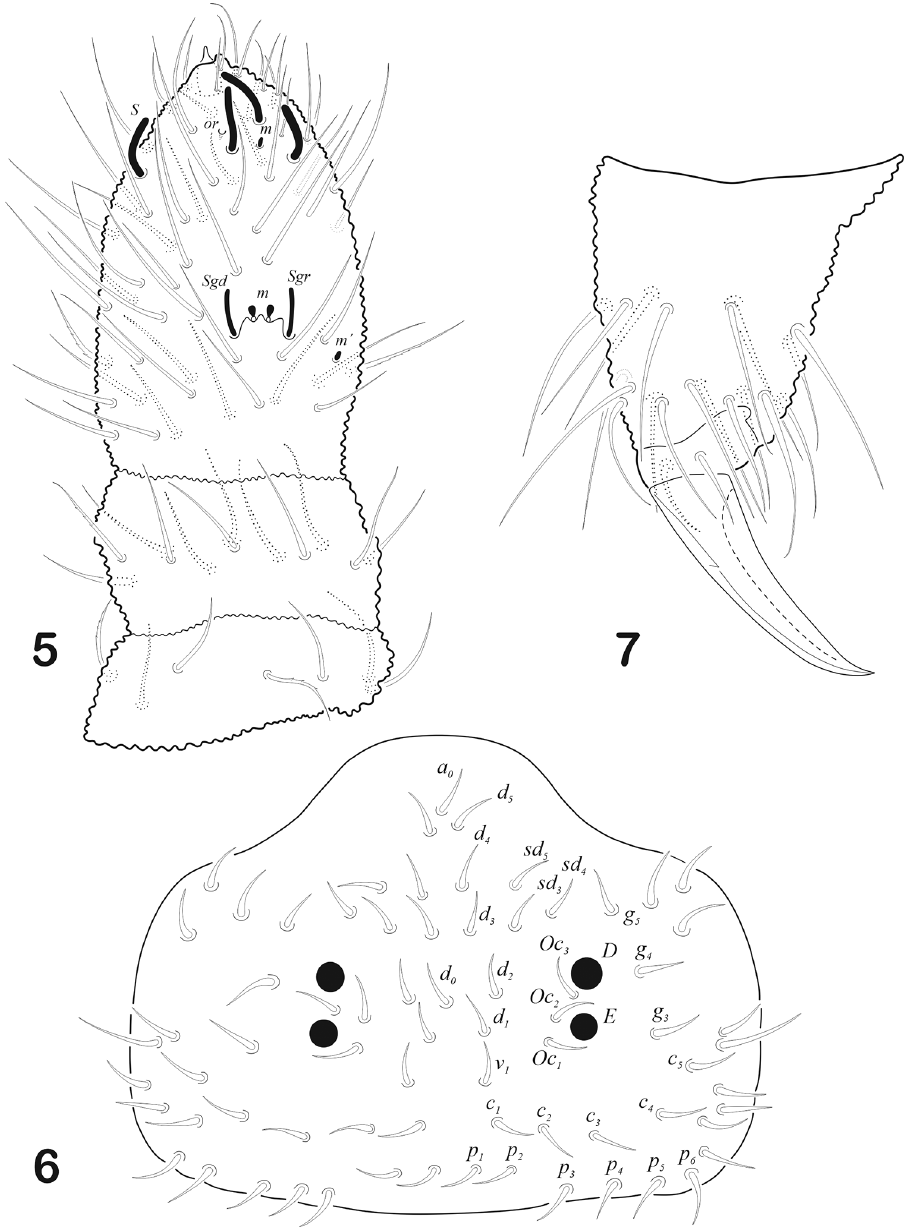
and 1 + 1 eugenital setae. Genital plate of male with 3 + 3 pregenital, 44 circumgenital and 4 + 4 eugenital setae. Each anal valve with 13 regular and 1 hr setae. Variation. Some asymmetries on body chaetotaxy were observed. Several speci- mens have setae somehow displaced, giving the appearance of asymmetries. One